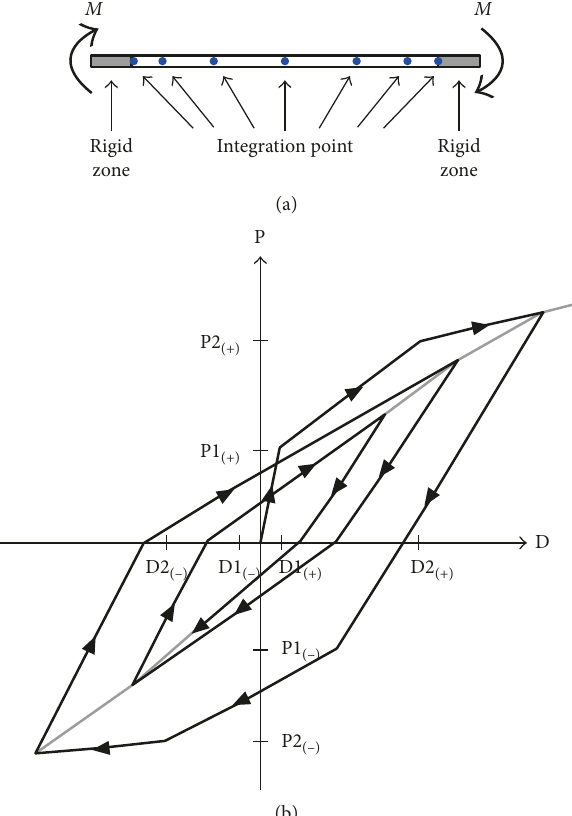
Figure 7: Takeda-type trilinear inelastic model for beam-column elements [51]: (a) distributed-type hinge model; (b) Takeda-type trilinear